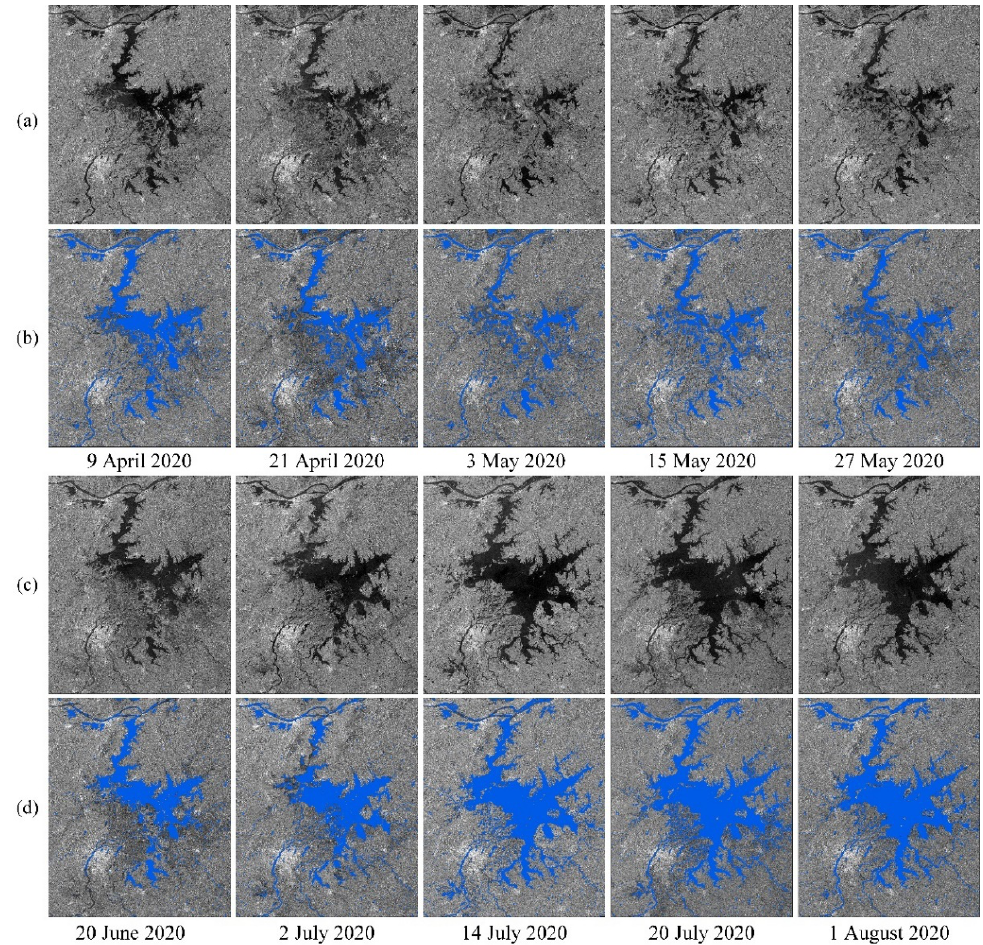
Figure 15. Monthly water extraction results of Poyang Lake in 2020. ( a , c ) represent Sentinel-1 SAR images; ( b , d ) correspond to the water extraction results of ( a , c ) superimposed on the SAR image.